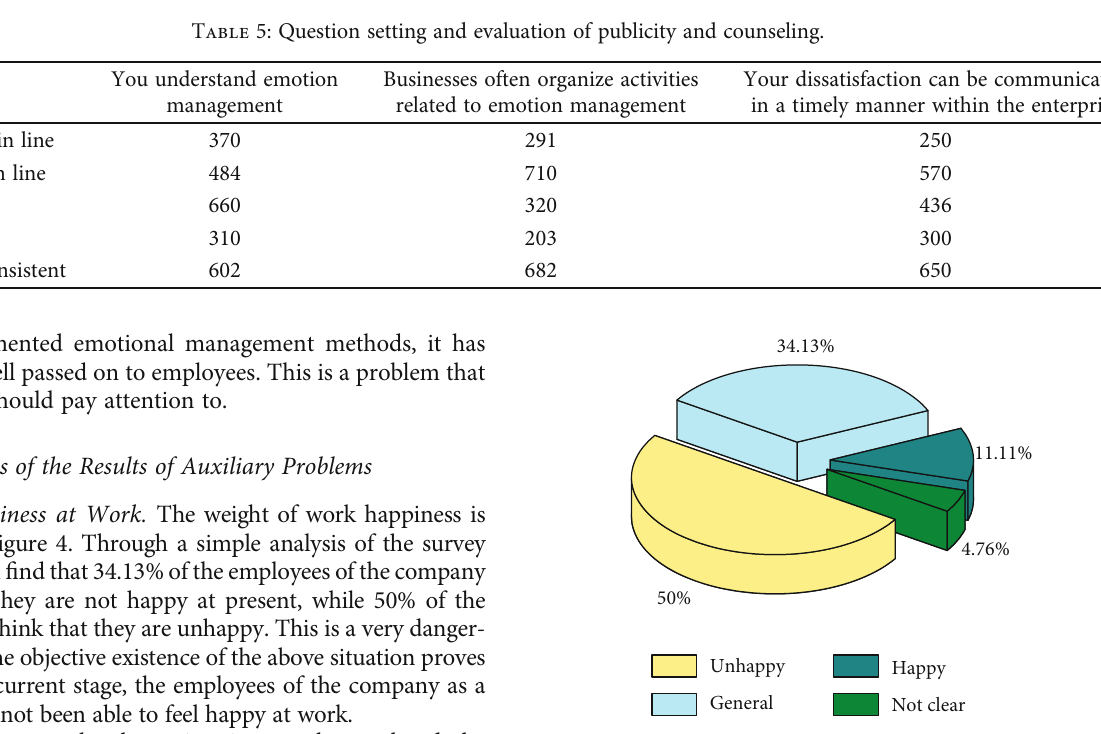
Figure 4: Weight of work